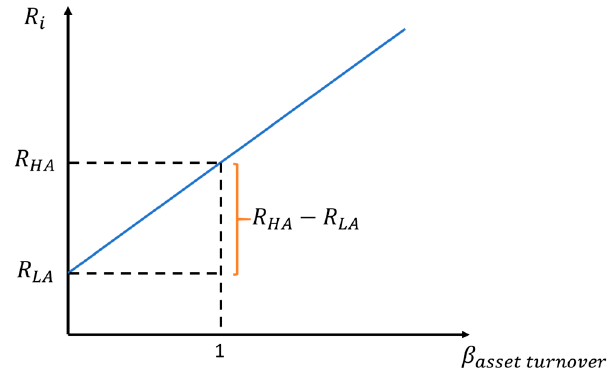
Figure A8. Positive relationship between expected return and asset turnover premium.